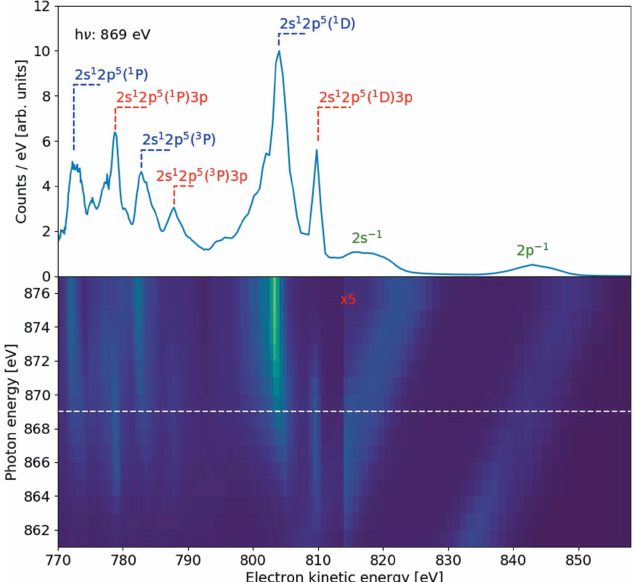
Figure 7 Electron spectra of Ne measured at the SQS instrument in the region of the 1 s resonances and threshold. The spectrometer is horizontal, perpendicular to the photon beam. Bottom panel: spectra at several photon energies near the 1 s threshold. The portion at electron energies >813 eV is scaled (cid:8) 5 for visibility purposes. Upper panel: spectrum at a photon energy of 869 eV, corresponding to the dashed line in the bottom panel. Assignments for some of the peaks are in the upper panel: blue are normal Auger, red are resonant Auger and green are photolines.